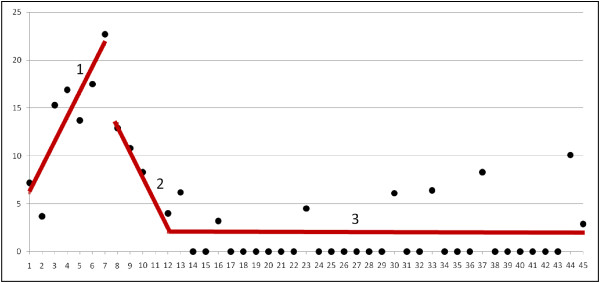
Segmented regression of ventilatorassociated pneumonia (VAP) rateper 1,000 ventilator daysfrom April 2007 toDecember 2010. Segmented 1: β10 = +6.08 p = 0.004; CI 95%: [(2.06 - 10.12)]. Segmented 1 (the slope): β11 = +2.59 p <0.001; CI 95%: [(1.47 - 3.71)]. Segmented 2: β20 = −11.24 p = 0.004; CI 95%: [(−18.60) - (−3.89)]. Segmented 2 (the slope): β21 = −2.30 p = 0.272; CI 95%: [(−6.48) - 1.88)]. Segmented 3: β30 = −2.67 p = 0.682; CI 95%: [(−15.83) - 10.47)]. Segmented 3 (the slope): β31 = +0.03 p = 0.610; CI 95%: [(−0.08) - 0.13)].